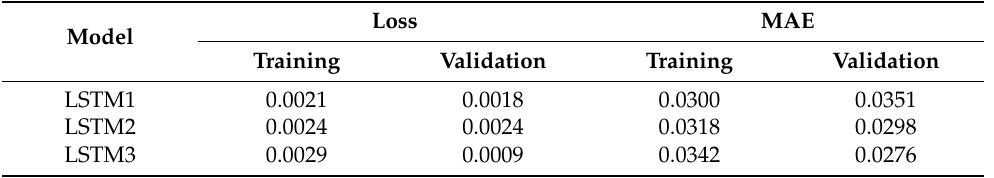
Table 5. Results of loss and MAE for training and validation. The loss and MAE values in the table were the best values among 100 epochs.